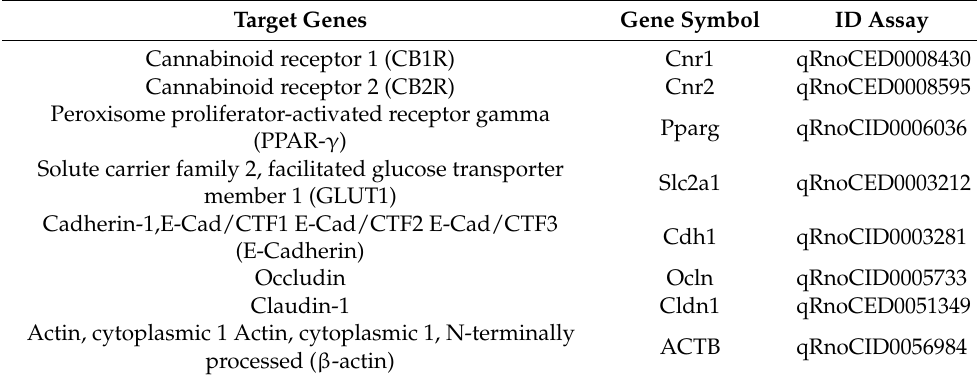
Table 2. Primers for quantitative real-time Polymerase Chain Reaction